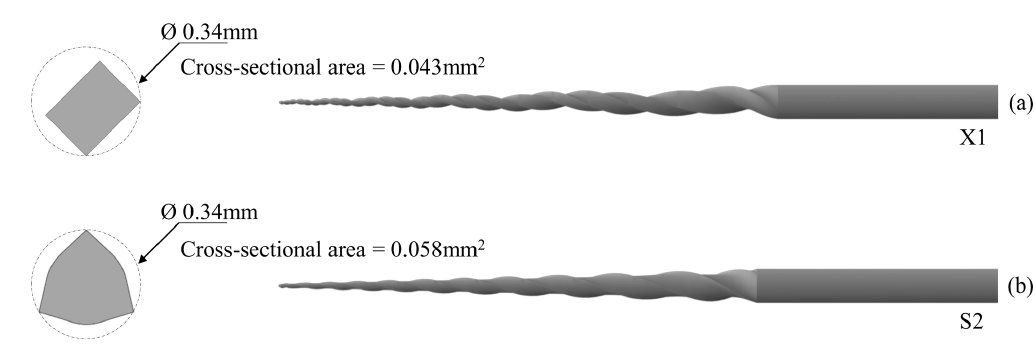
Figure 1. Geometric model and cross-section at 3 mm from the tip of the analyzed files: (a) X1 and (b) S2.